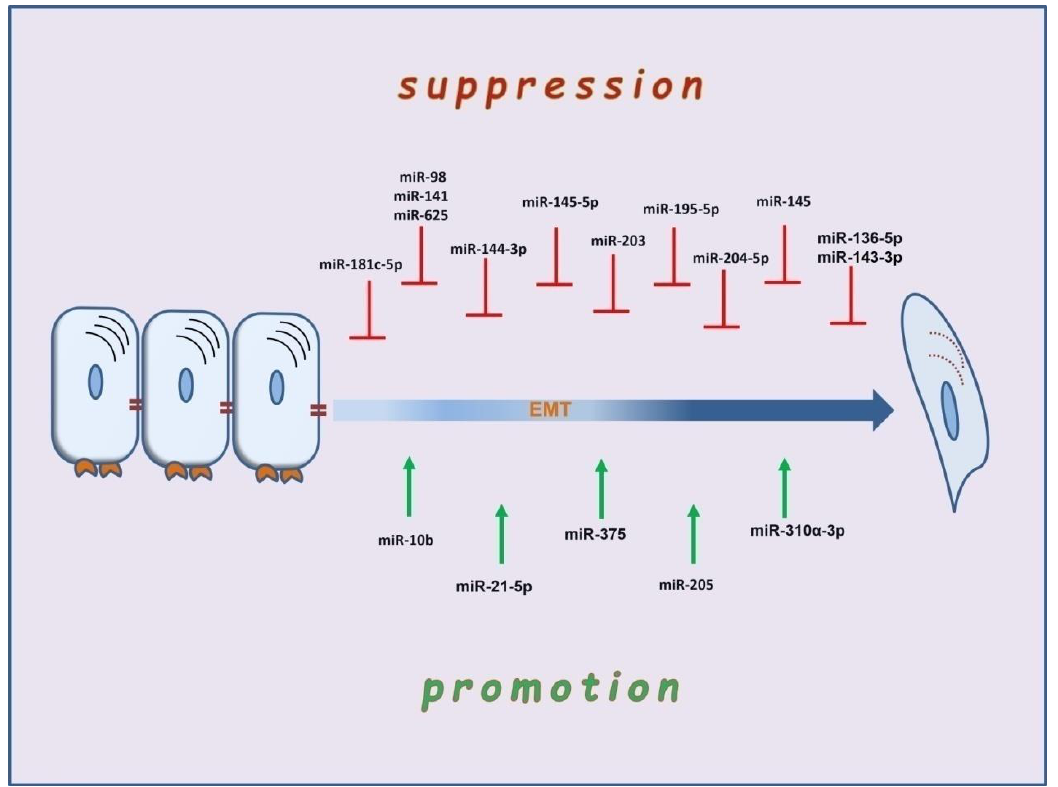
Figure 2. The multifaceted role of microRNAs in suppression and promotion of EMT in laryngeal